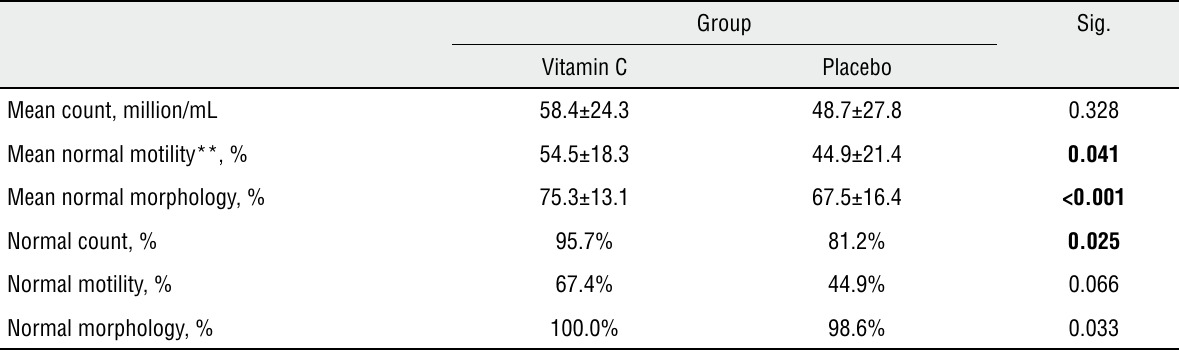
Table 2 - Comparison of the results of the surgery between the intervention and placebo group*